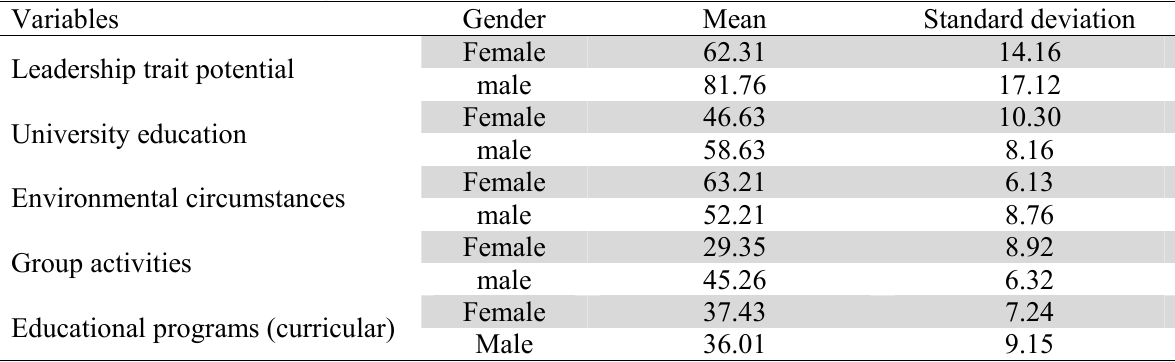
Summary statistics of both genders